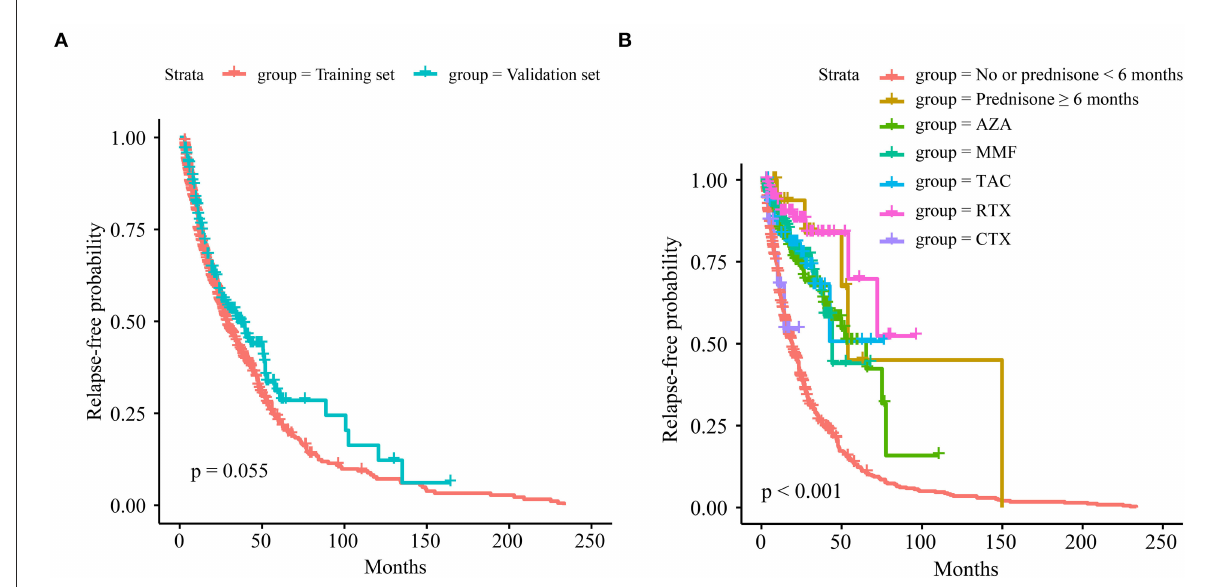
FIGURE1 The relapse curves. (A) Of the training and validation sets. (B) Of each maintenance therapy in the training set.